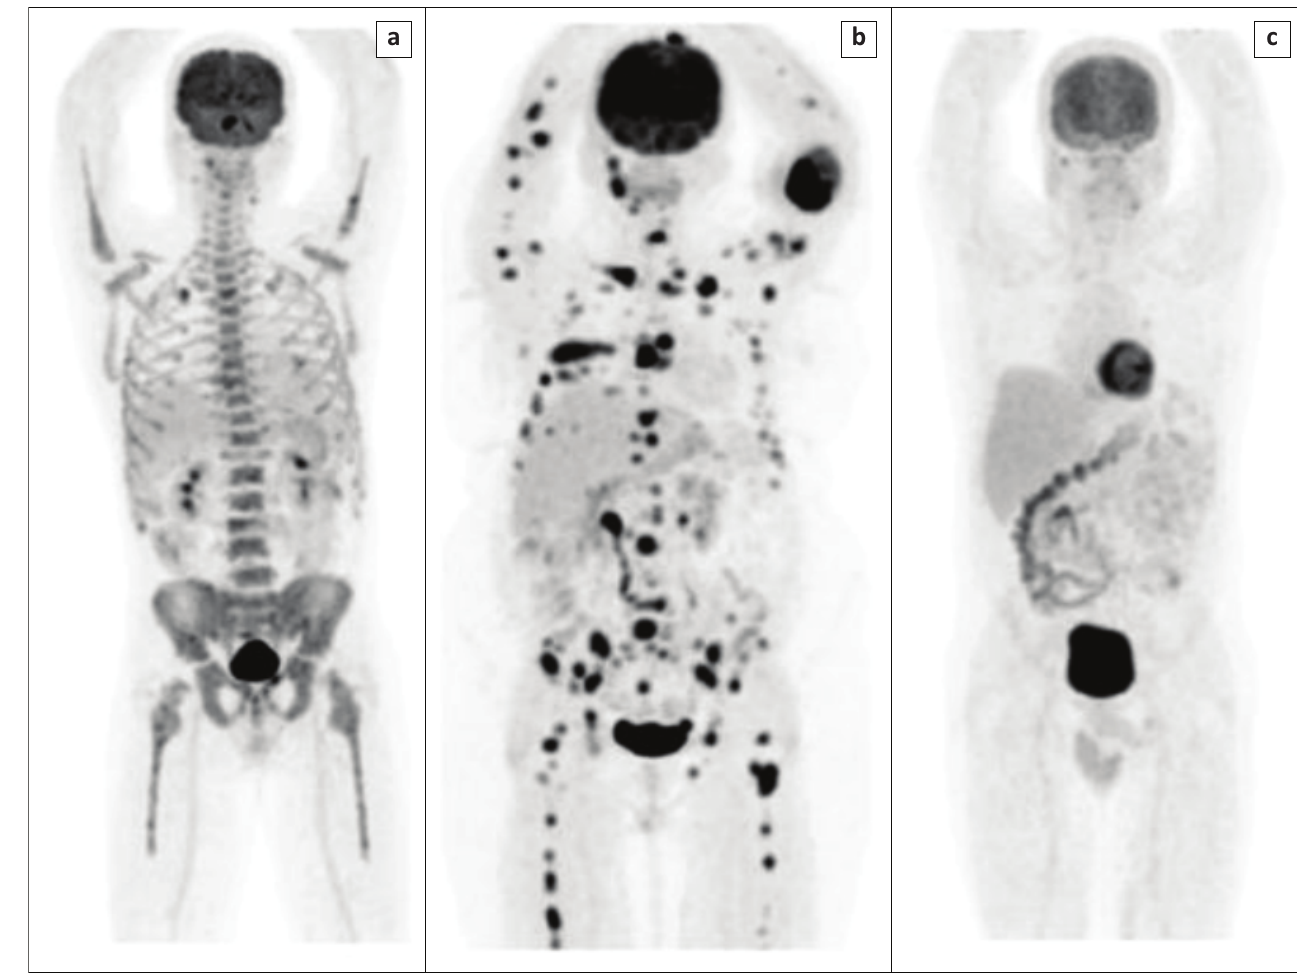
FIGURE 2: The three patterns of 18 F-FDG uptake in three of the study patients. (a) Diffuse greater than liver; (b) irregular and (c) diffuse less than or equal to